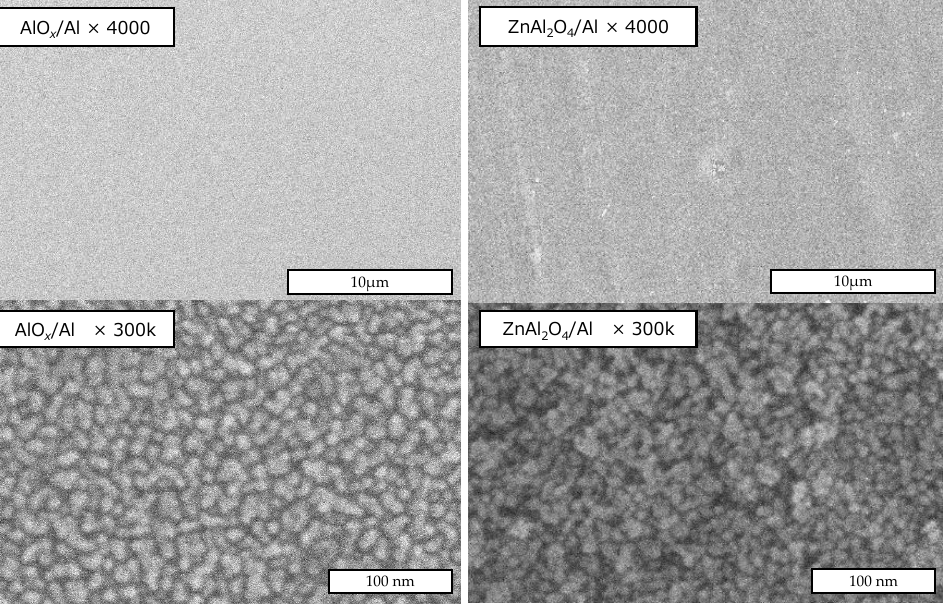
Figure 4. SEM images of the surface of the anodized AlO x layer ( left side ) and hydrothermally synthesized ZnAl 2 O 4 layer ( right side ).